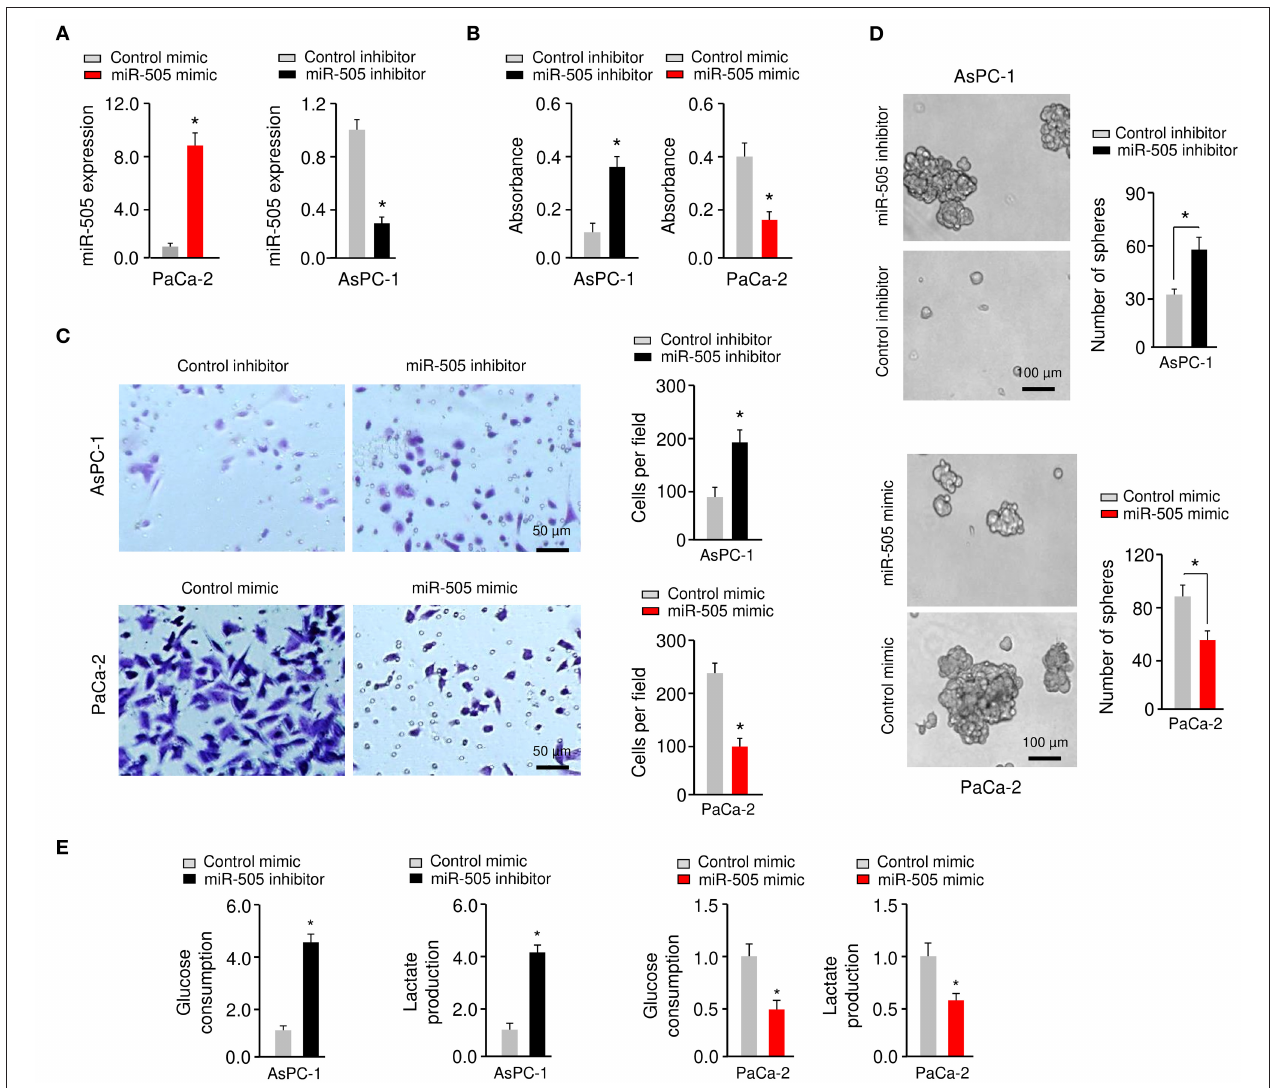
FIGURE 2 | miR-505 inhibits the proliferation, invasion, sphere formation, and glycolysis of PC cells. (A) Expression of miR-505 in PC cells transfected with miR-505 mimic, miR-505 inhibitor or their negative controls, respectively. (B) Cell proliferation was analyzed using CCK-8 assays. (C) Invasion of PaCa-2 (upper) cells was examined after miR-505 overexpression. Invasion of AsPC-1 (bottom) cells was examined after knockdown of miR-505. Scale bar: 50 µ m. (D) PC cells were transfected as indicated, and sphere formation assays were conducted. Scale bar: 100 µ m. (E) Glucose consumption and lactate production assays in PaCa-2 cells after overexpression of miR-505, and in AsPC-1 cells after knockdown of miR-505. * P <